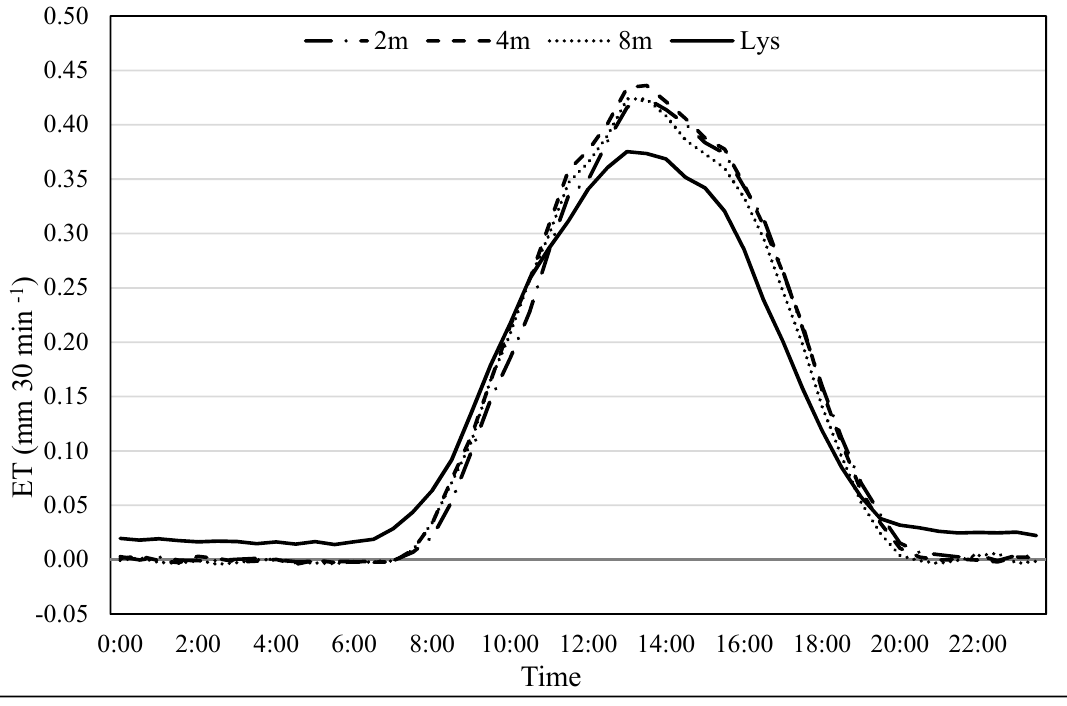
Figure 5. Evapotranspiration (ET) averaged for each 30-min interval across the entire growing season for the lysimeter and the three eddy covariancesystems.